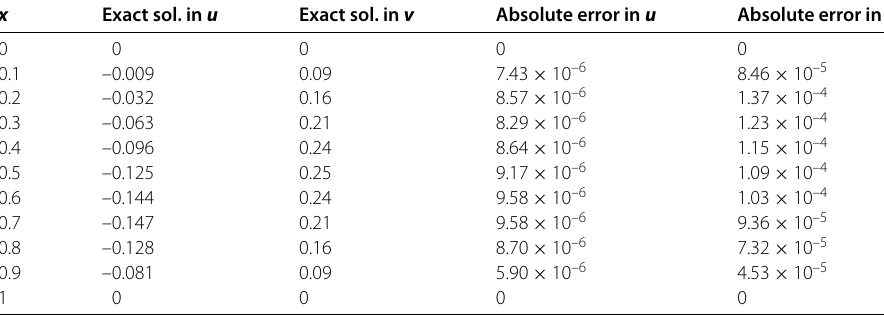
Table 4 Numerical results for Example 2 when N =